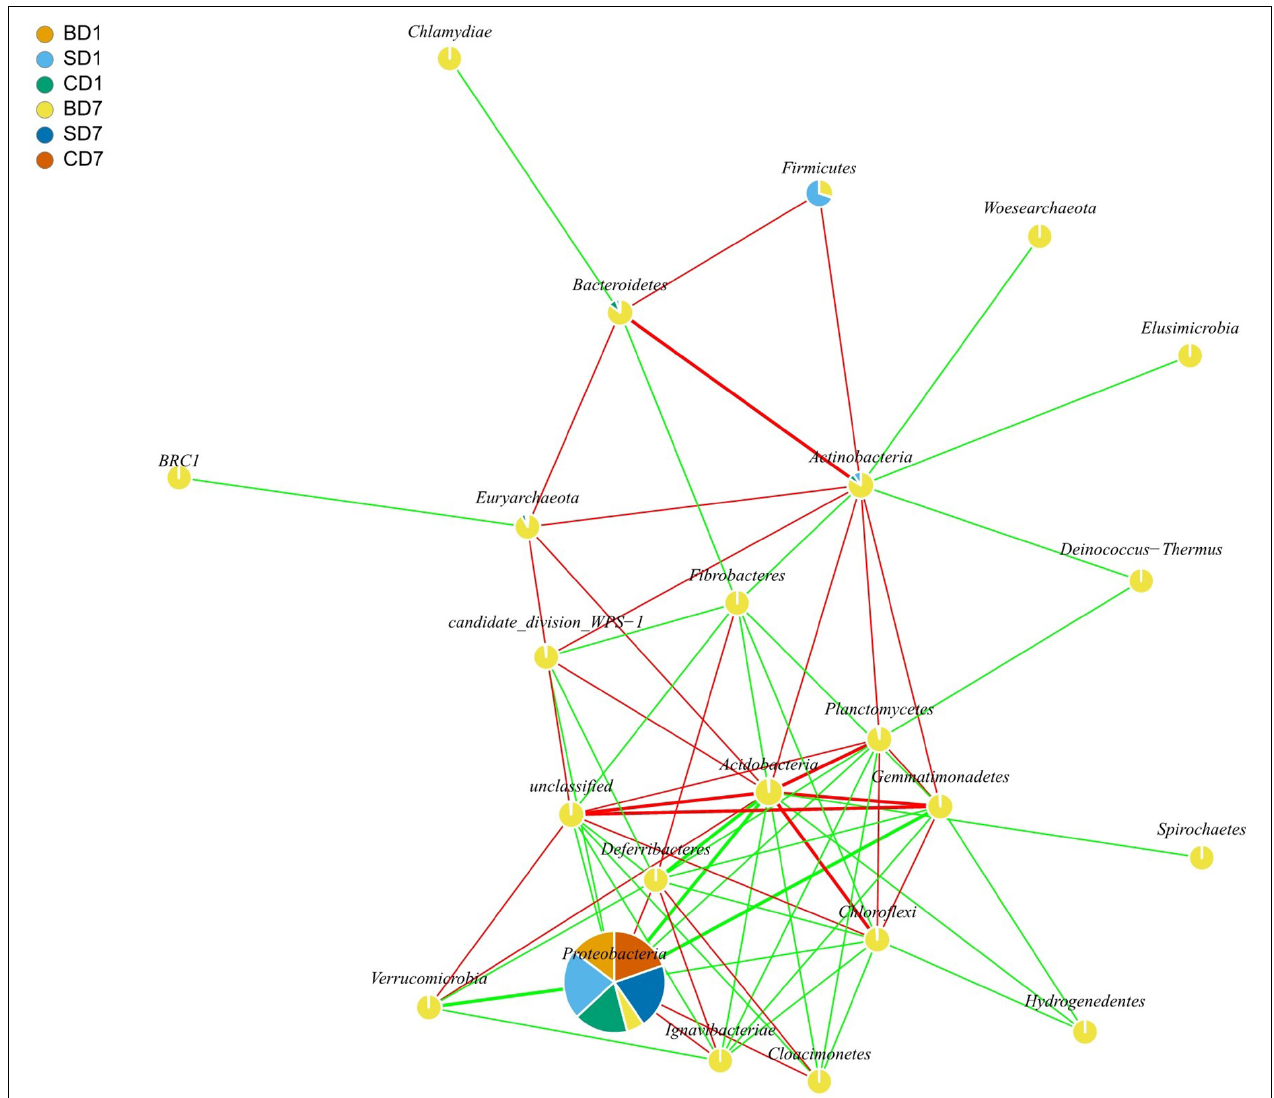
FIGURE 3 | Network interaction graph for microbial communities of BD, SD, and CD groups at the phylum level, using SparCC approach (Friedman and Alm, 2012). Each node represents a bacterial phylum, each color in a node represents a relative abundance of a sample. When a p -value is between 0.01 and 0.05, the correlation is significant, and a dashed line is used; when a value is p < 0.01, the correlation is highly significant, and a solid line is used. When the correlation is positive, a red color line is used; when a correlation is negative, a green color line is used. When a correlation coefficient is > 0.8, a thick line is used; when a correlation coefficient is < 0.8, a thin line is used. In drawing this graph (with igraph package in R software), only those data that showed correlation coefficients higher than 0.6 in absolute value and were statistically significant ( p < 0.05) were used. For the sake of simplicity as well as for showing more data, interactions at the phylum level are shown here rather than at the order level, which was given in the form of Supplementary Table S2 . BD1, SD1, and CD1 represent PL samples at day 1 of the test, and BD7, SD7, and CD7 represent PL samples at day 7.